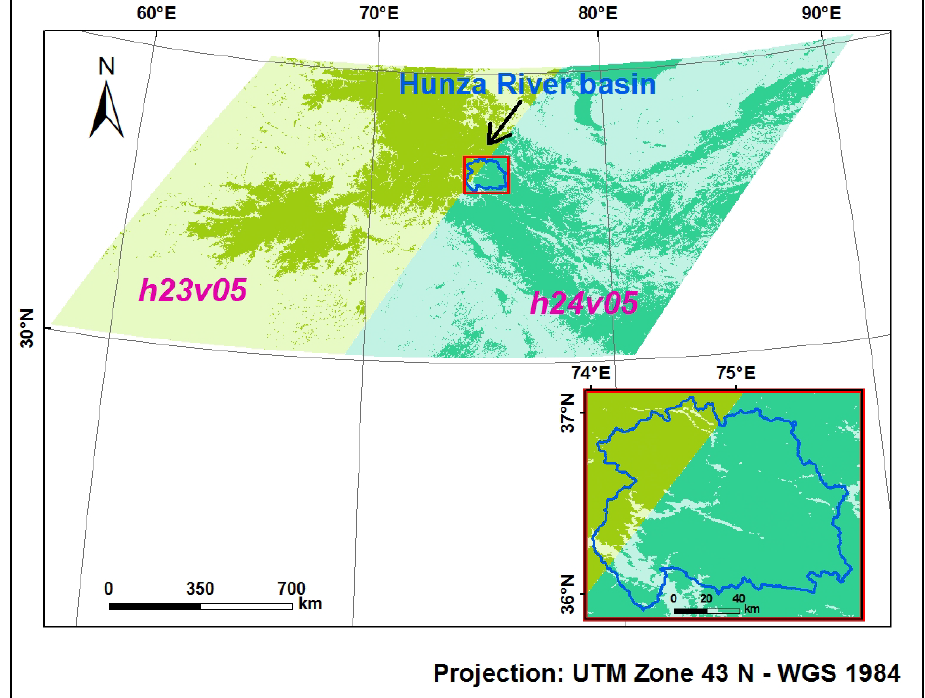
Figure 2. Example of MODIS mosaicked tiles (h23v05 and h24v05), dated 1 January 2001 to cover the study area (Hunza River basin).